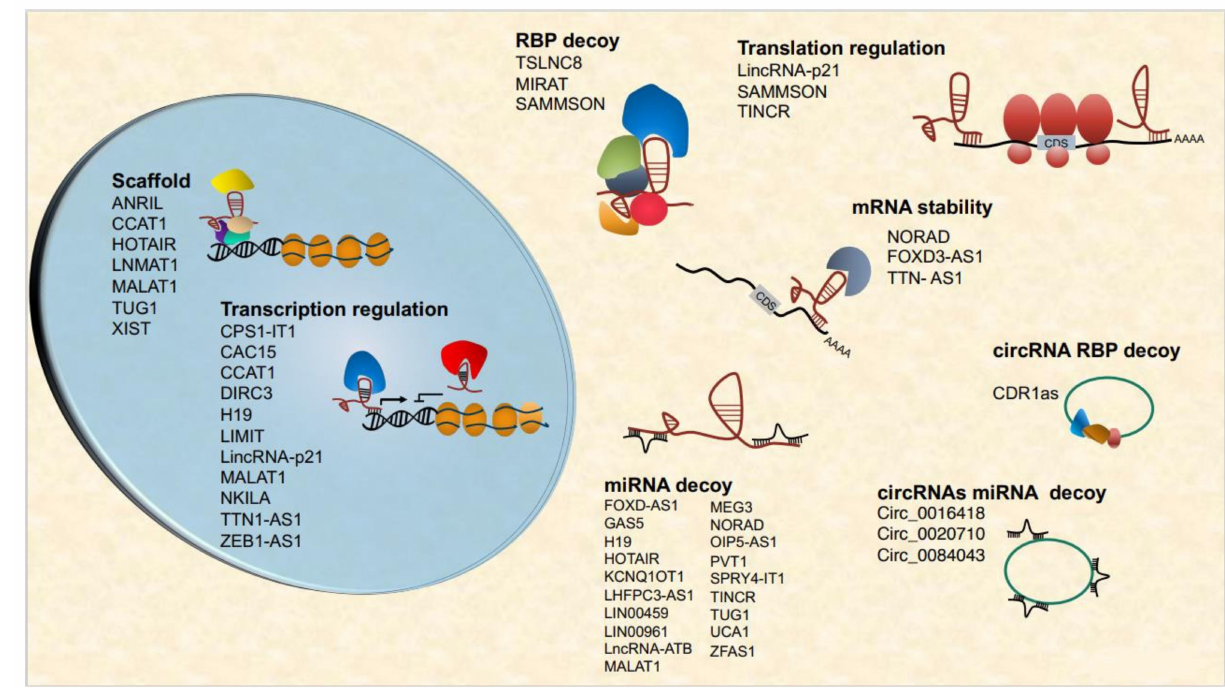
Figure 2. Major functional classes of nuclear and cytoplasmic lncRNAs involved in melanoma progression. From the translational point of view, lncRNAs are emerging as previously underesti- mated therapeutic and diagnostic targets. Given the restricted, cancer-specific expression of many oncogenic lncRNAs, their diagnostic testing as cancer biomarkers in liquid biopsies held great promise. Ongoing massive efforts in the field of RNA-therapeutics will allow the exploitation of the usage of lncRNA as efficient drugs in the modulation of melanoma growth and its interaction with the immune